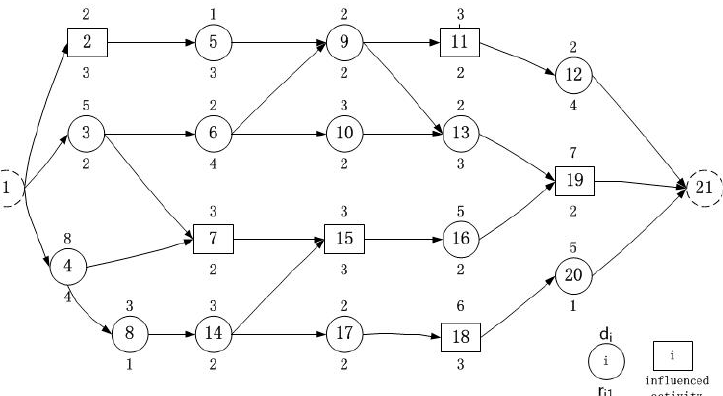
Figure 1. Sample project.